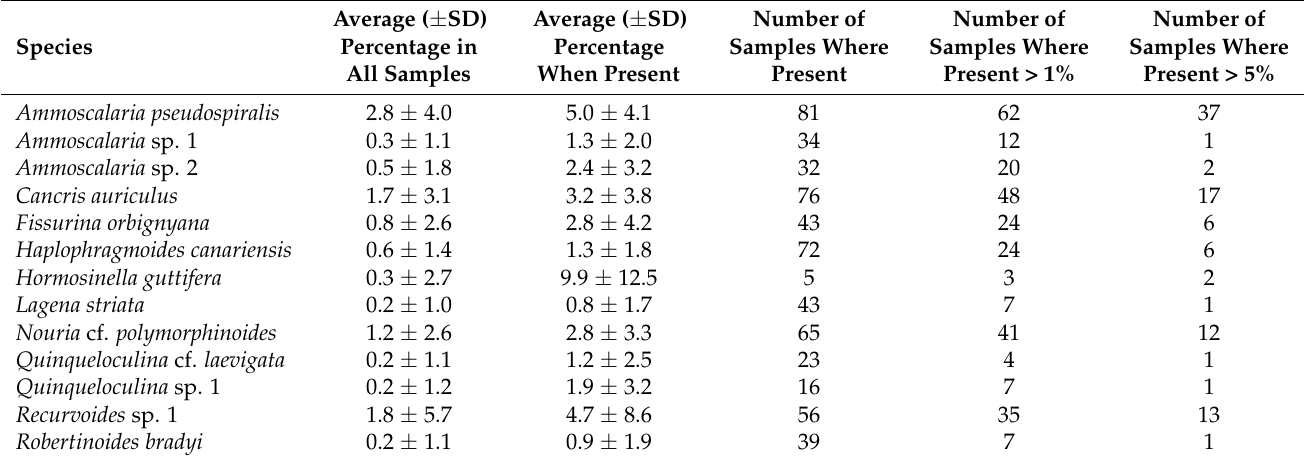
Table 3. Major species (i.e., at least present > 10% in one sample) unassigned by Jorissen et al. [21]. Total number of samples =